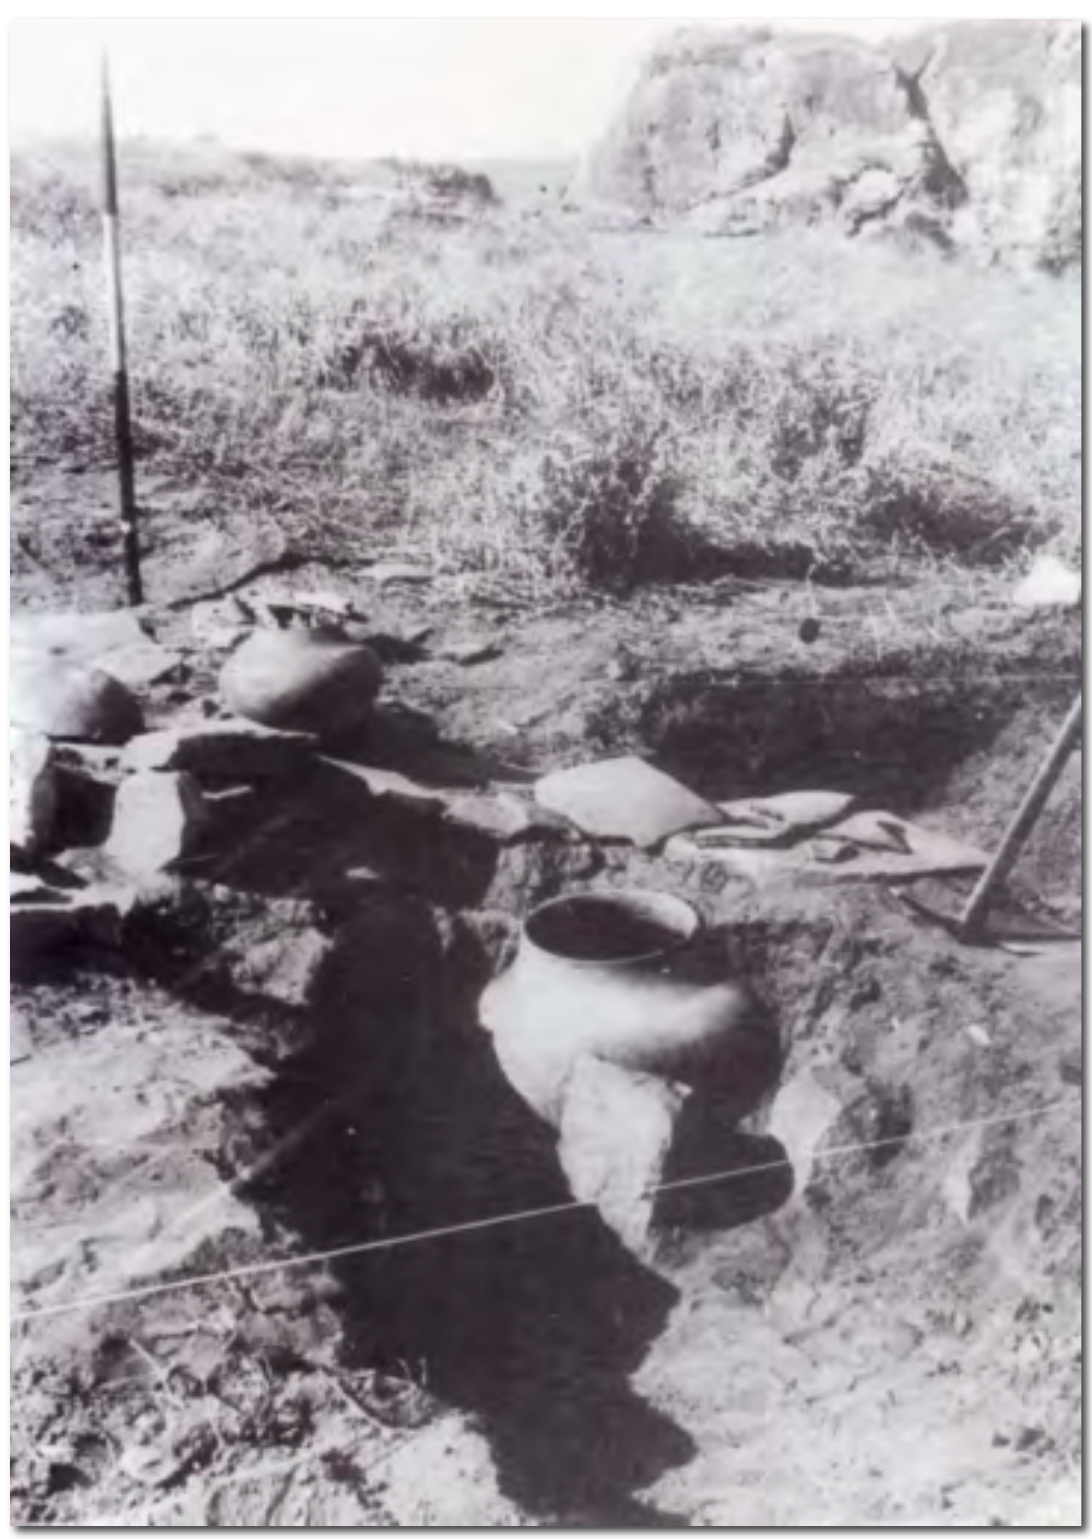
Figure 11. A large ceramic pot, apparently a storage vessel, sunken into the ground between or close to vertically positioned columnar stones, exposed during initial excavations on Mapungubwe Hill in 1933 or 1934 (Meyer 1998: